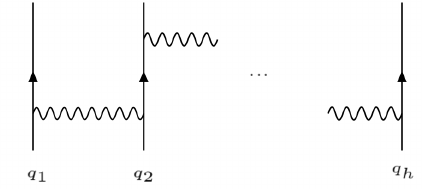
Figure 1. One-gluon exchange process involving h quarks.